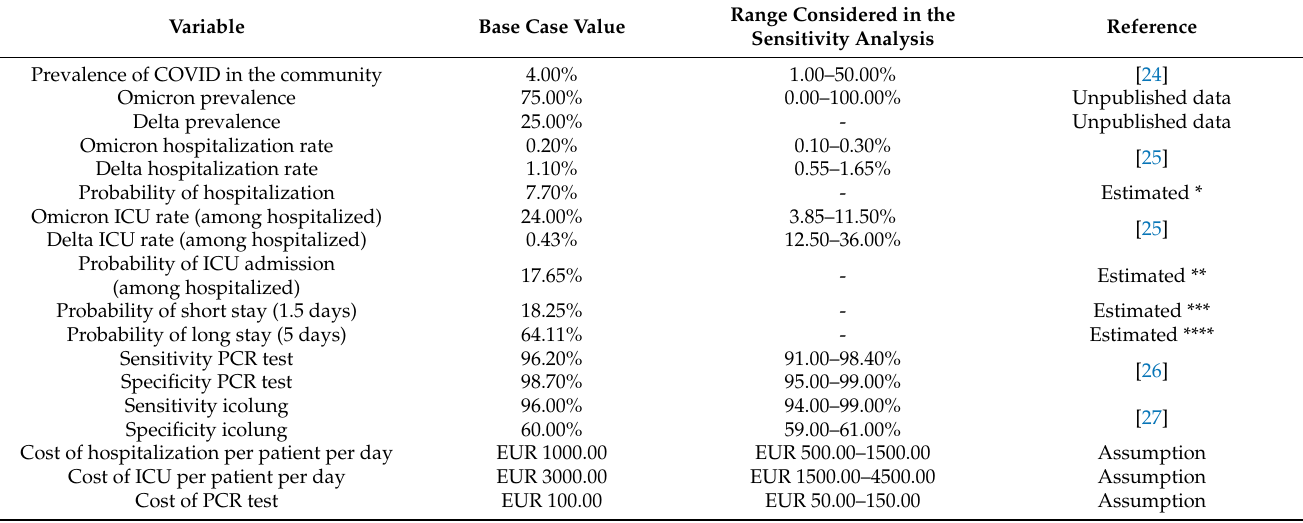
Table 1. Parameters and range used in our model for the sensitivity